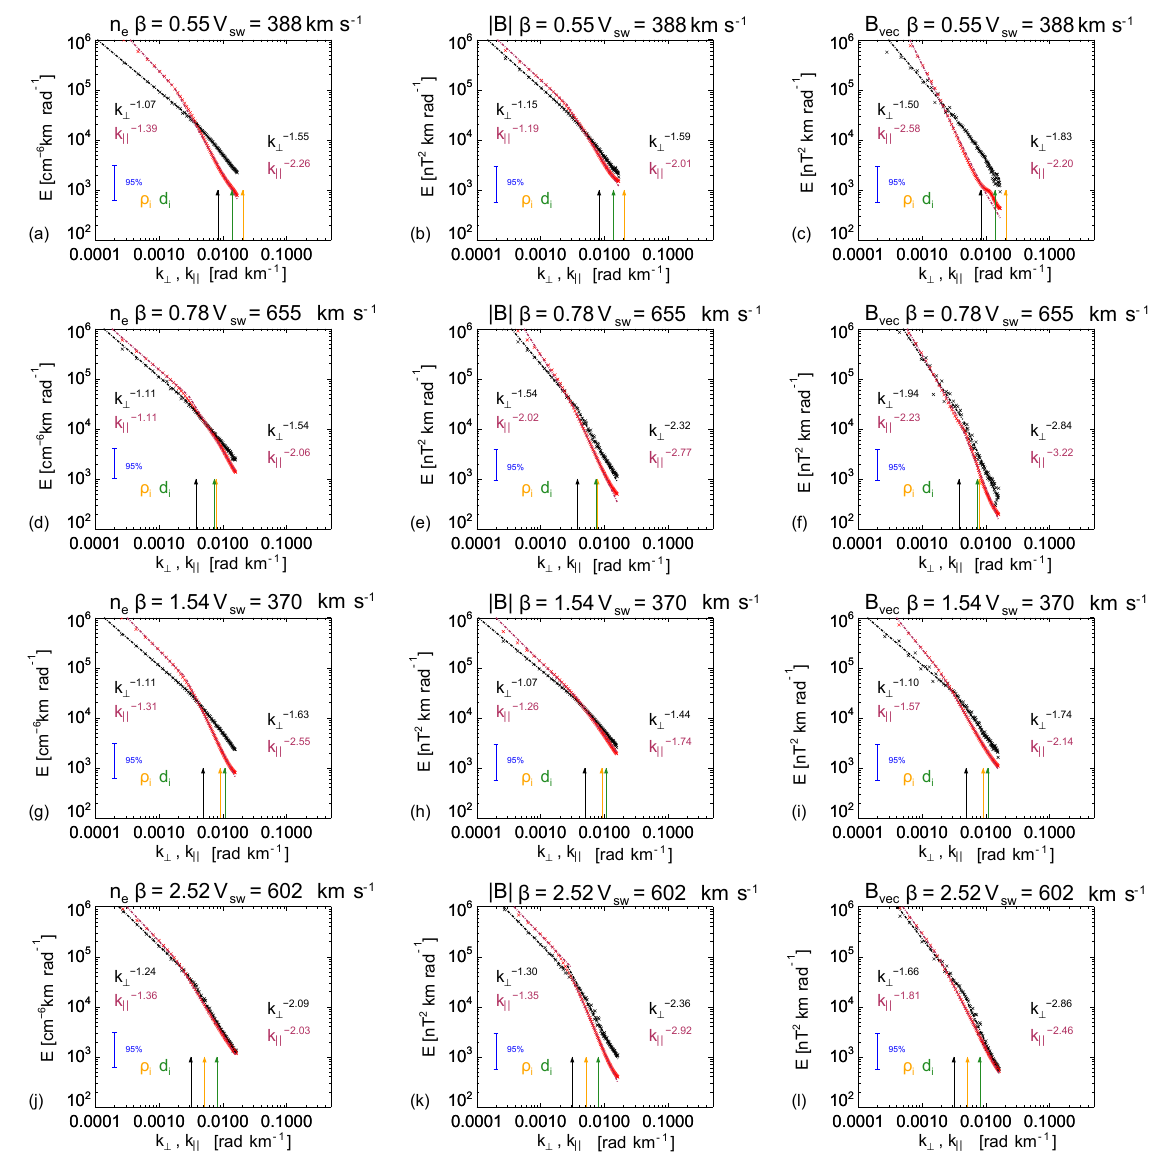
Figure 3. 1-D integrations of the two-dimensional spectra presented in Fig. 1, the labels correspond to the same spectra. Power laws are fitted to the spectra at the scales where the lines are present, the spectral index for the power law fits are given for the parallel and the perpendicular components. The 95% confidence level is also